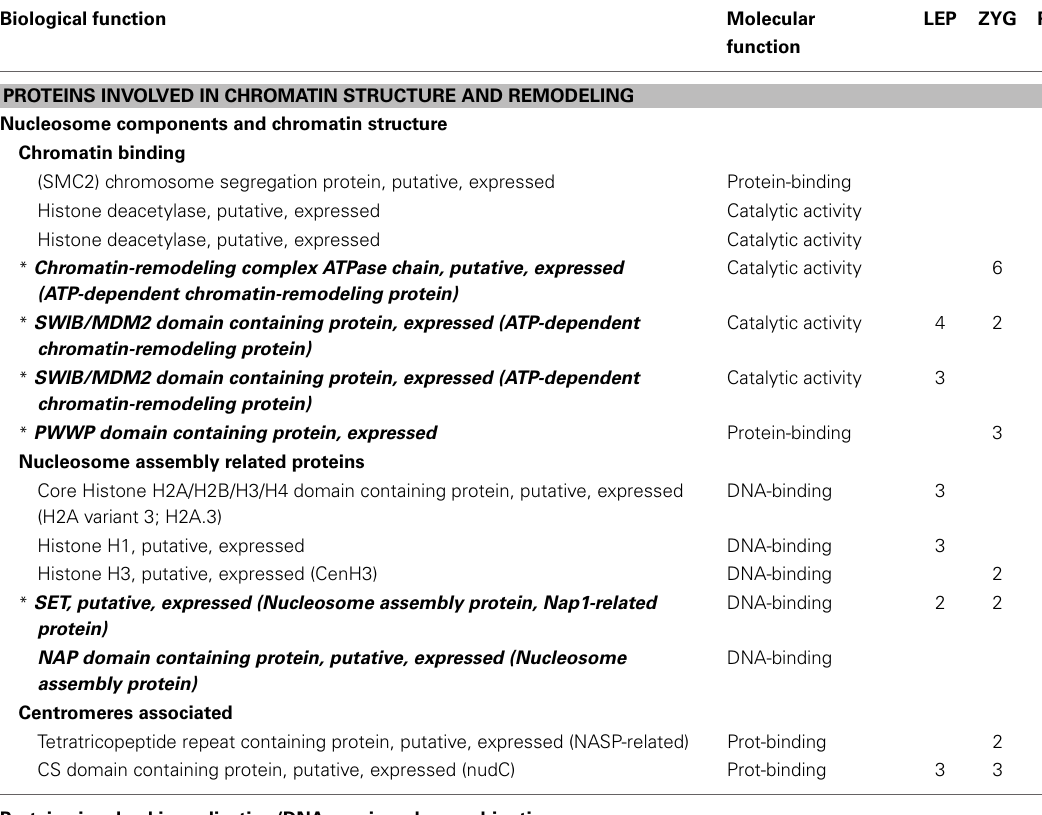
Table 1 | Proteins identified in rice isolated meiocytes at early prophase I associated to putative functions involved in chromosome